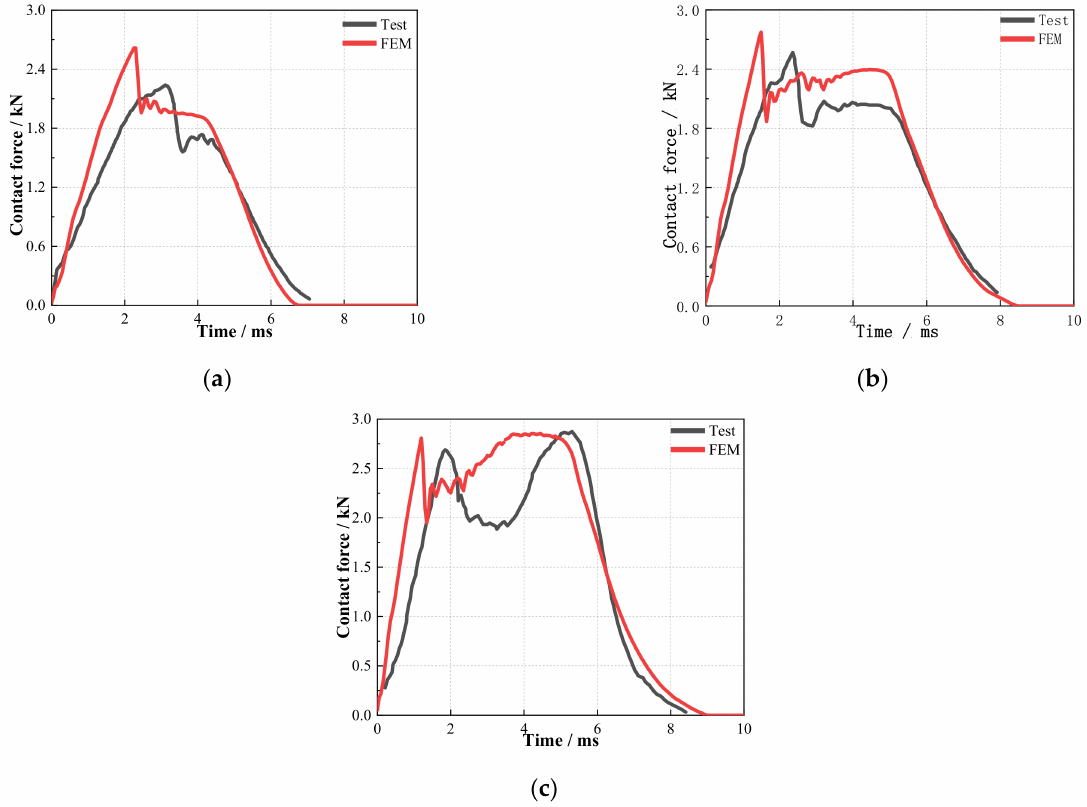
Figure 3. Comparison of test [13] with FE Contact force − Time curves at 10 J, 20 J, and 30 J impact energy. ( a ) 10 J; ( b ) 20 J; ( c ) 30 J.